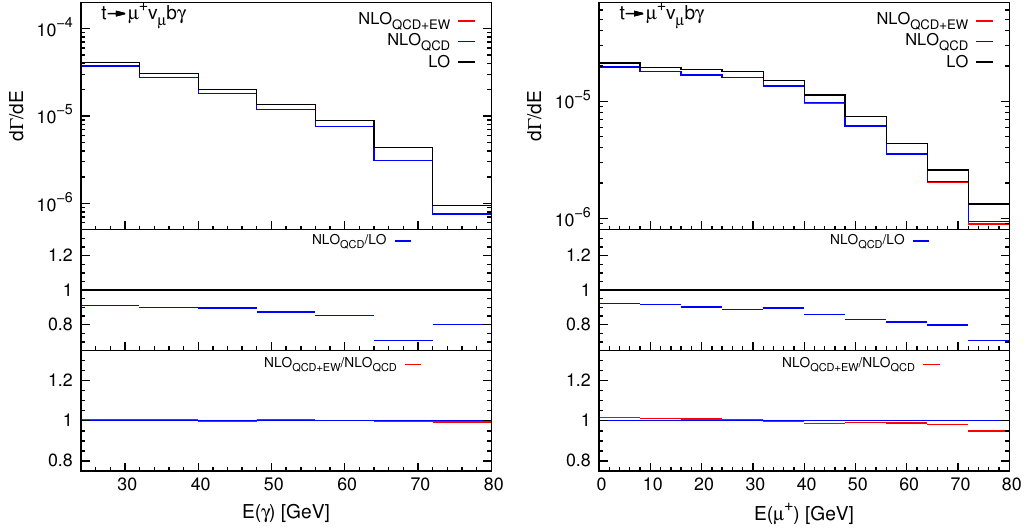
Figure 4 . Differential distributions for leptonic top-quark ( t → b‘ + ν ‘ γ ) partial decays, with ‘ = µ